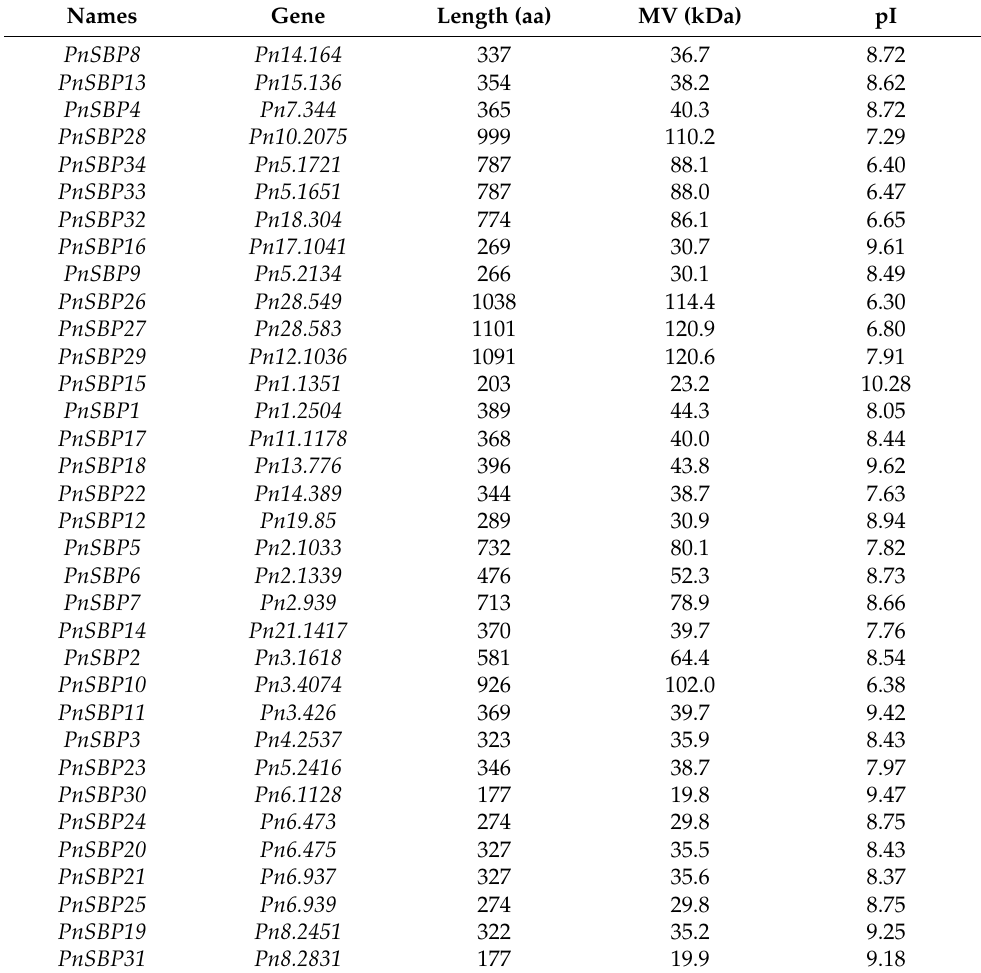
Table 1. The basic information of pepper SBP